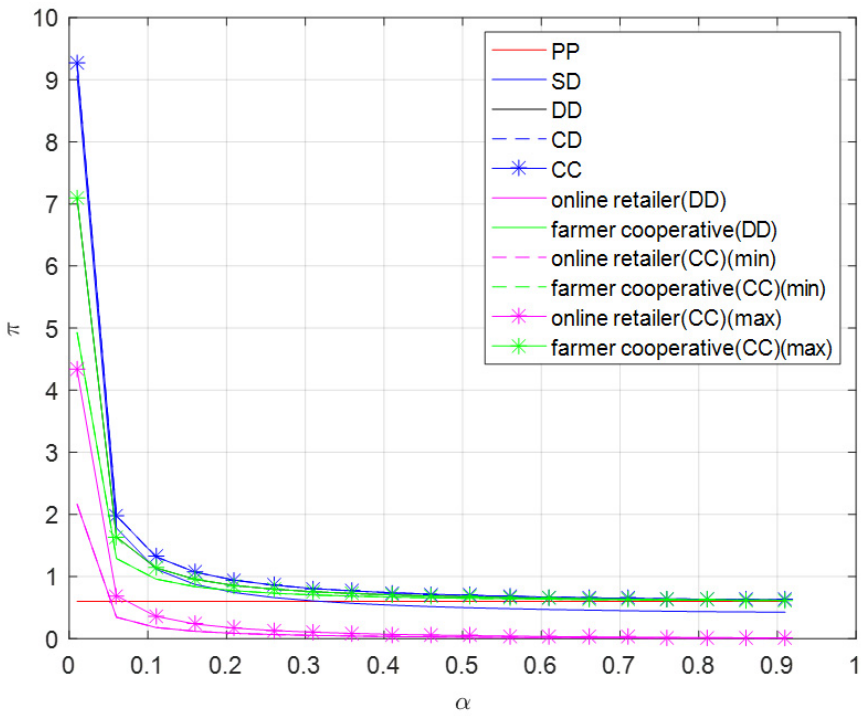
Figure 2. Optimal profit versus α .